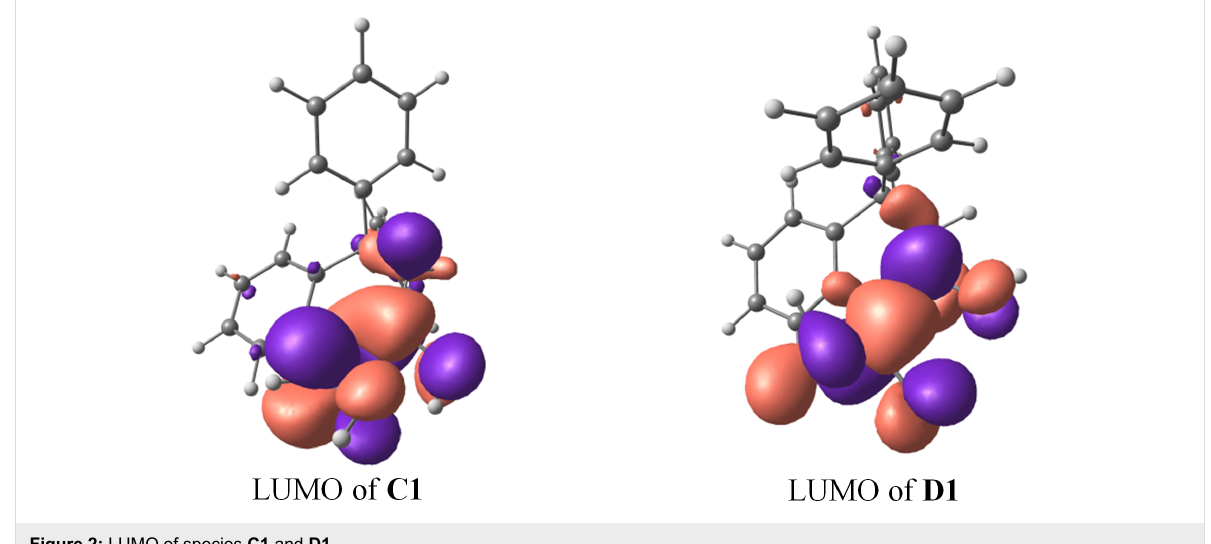
Figure 2: LUMO of species C1 and D1 .